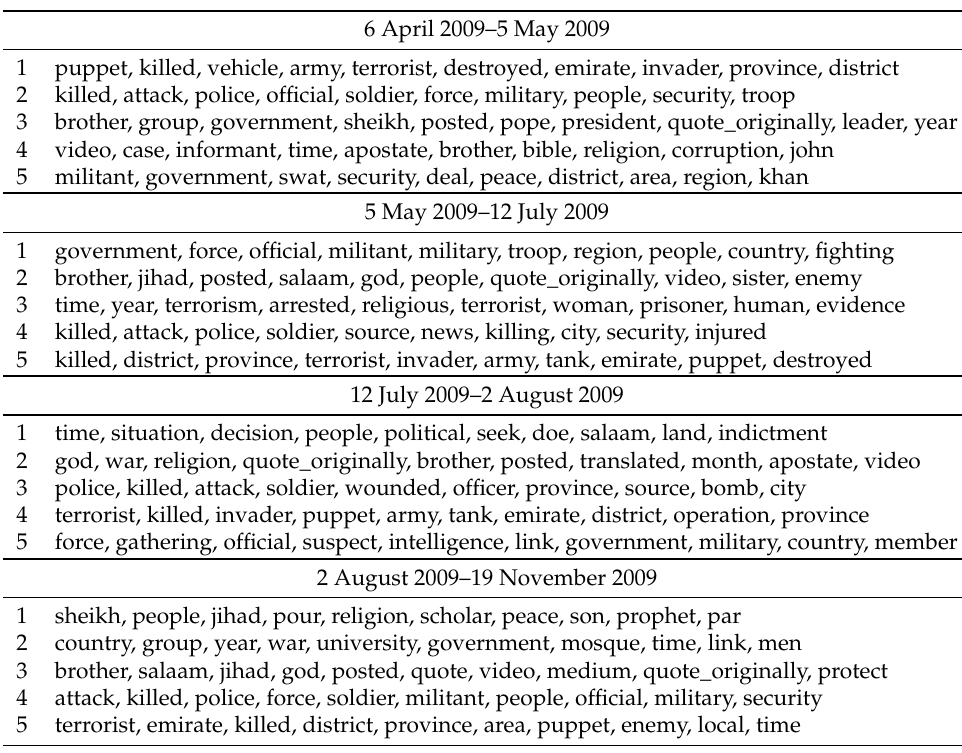
Table 7. Topics per time